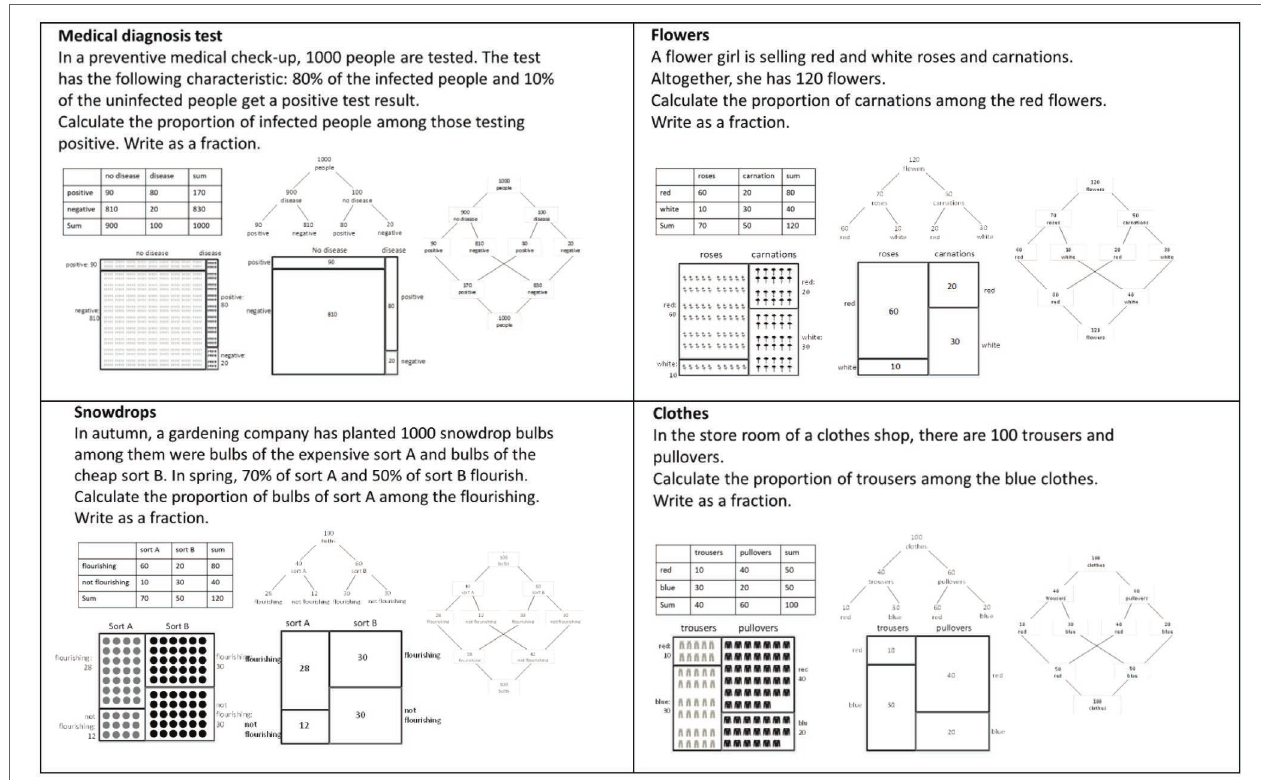
FIGURE 4 | The test-items for investigating students’ performance when solving Bayesian reasoning tasks. The original test-items showed only one